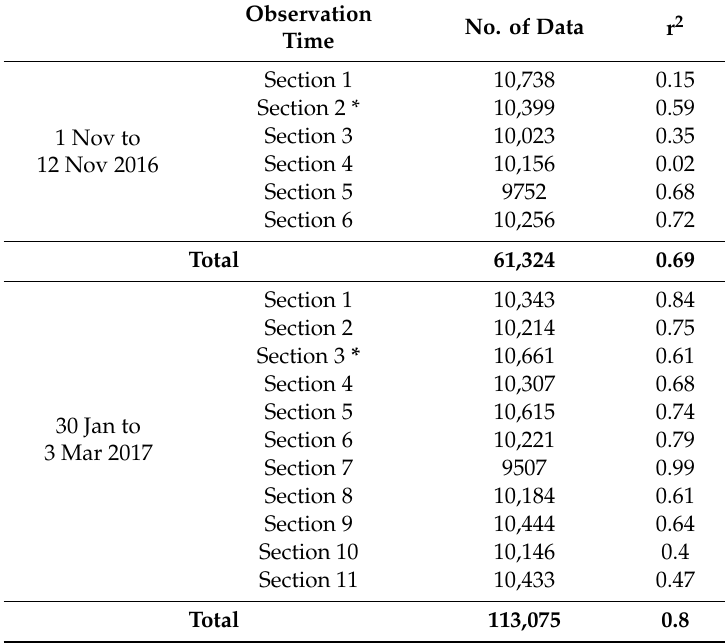
Table 1. Results of linear regression analysis of eastward geostrophic currents with eastward ADCP currents for both deployments. Asterisks in the table indicate the sections of interest. Observation No. of Time